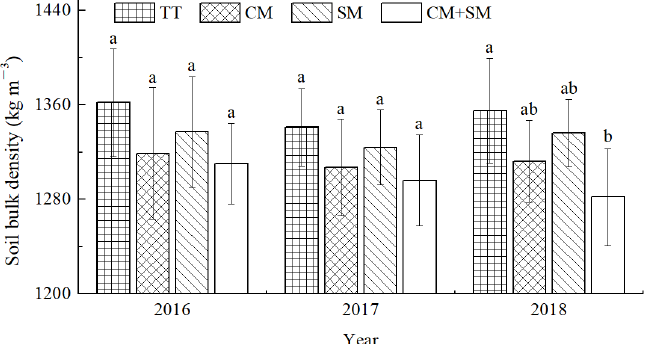
Figure 4. Mean soil bulk density to the depth of 0.30 m for traditional tillage (TT), cattle manure mixing (CM), maize straw mulching (SM), and combined manure mixing and straw mulching (CM + SM) treatments from 2016 to 2018. The data were measured after maize harvesting. Means in the same year followed by the same letter are not statistically different according to least significant difference test ( p = 0.05).